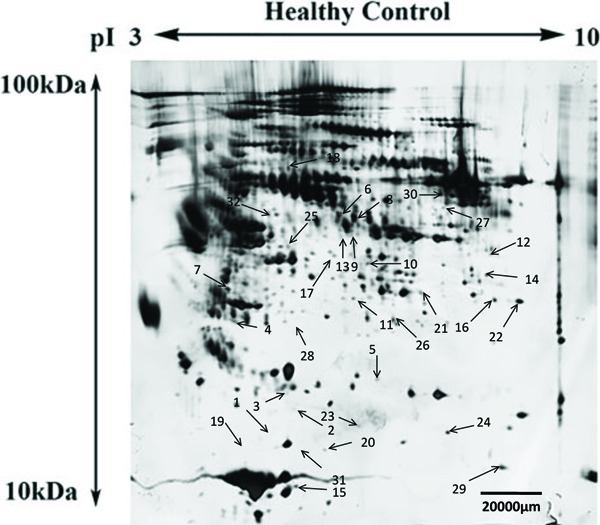
Representative image of a two-dimensional electrophoresis silver stained
gel of depleted plasma sampled from healthy control subjects. Thirty-two
differentially expressed protein spots (numbered with arrows) were identified
across various bipolar disorder (BD) mood states (depressed BD, manic BD, and
euthymic BD) relative to healthy controls.